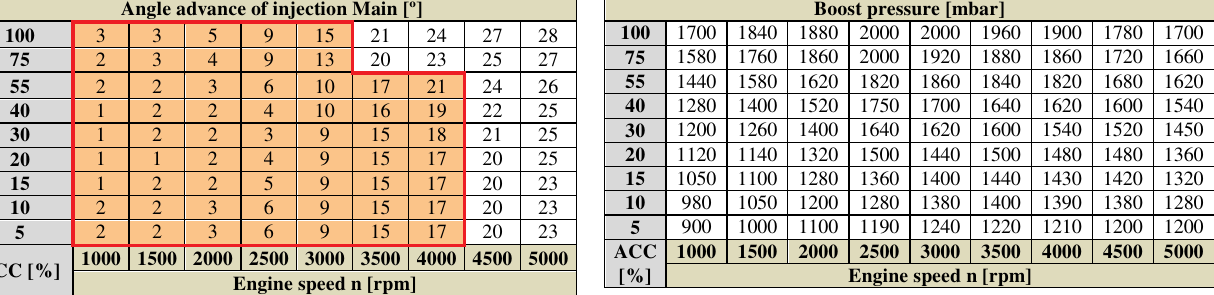
Table.7. Control algorithm of injection advance angle of Diesel oil for Main dose at dual fuel supply of the engine Angle advance of injection Main [º]